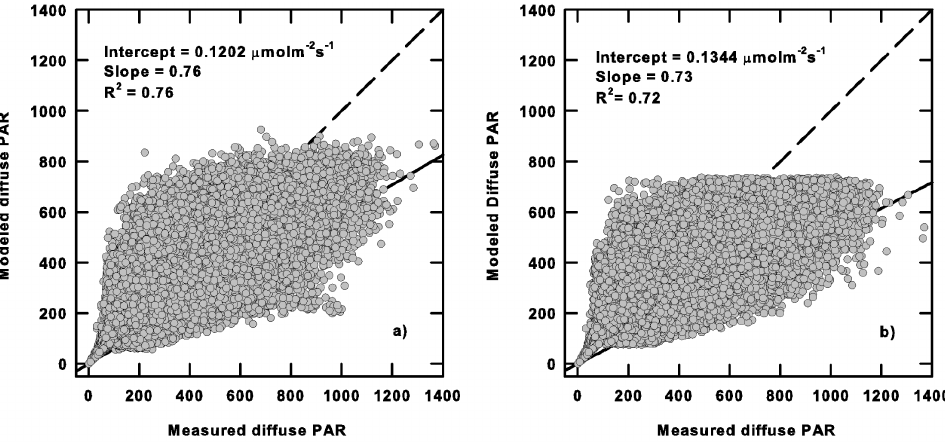
Figure 5. Comparison between measured and modeled diffuse PAR (a) logistic model (b) cubic polynomial model. The regression statistics presented are for the bootstrap regression between the measure and modeled variables. All units are in µmolm − 2 s − 1 .